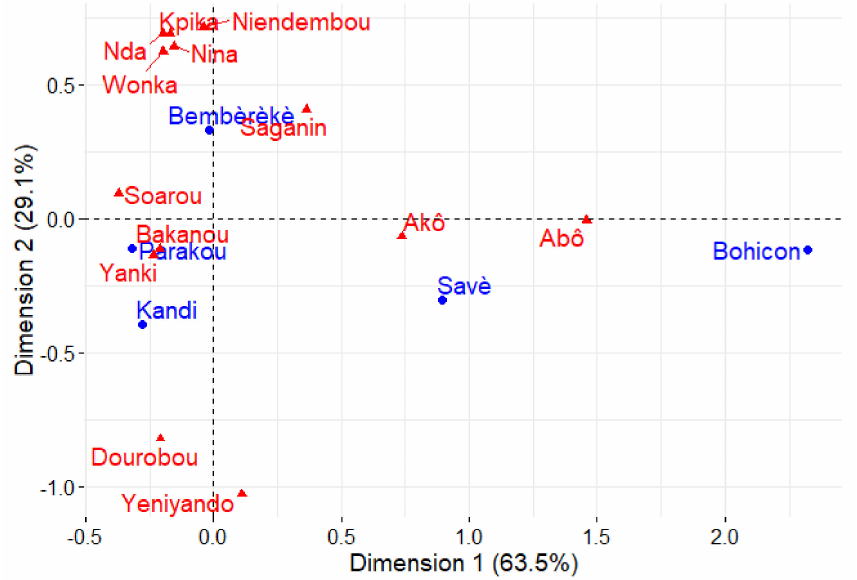
Figure 4. Factorial correspondence analysis biplot showing the main traits cited in the five shea parklands